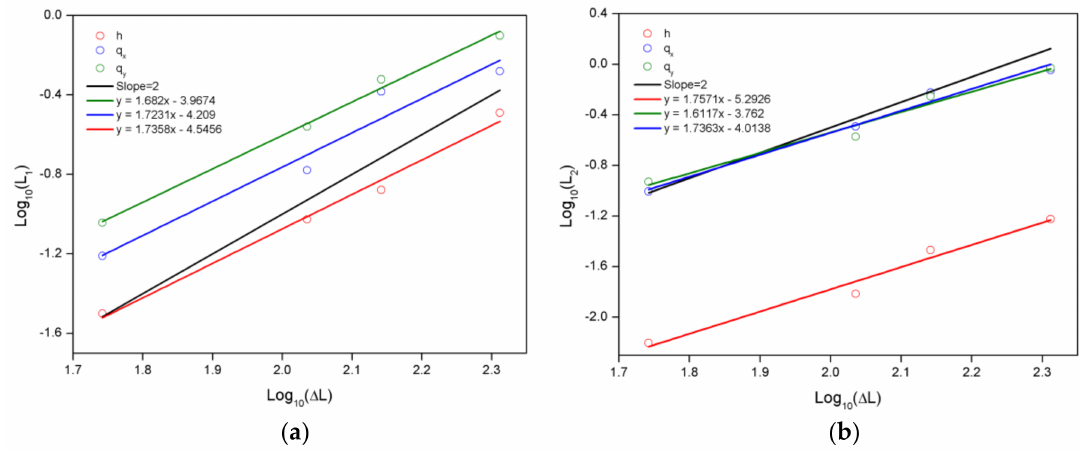
Figure 14. Errors of the numerical scheme in L 1 and L 2 norms at t = 3 T for h , q x and q y : ( a ) L 1 errors; ( b ) L 2